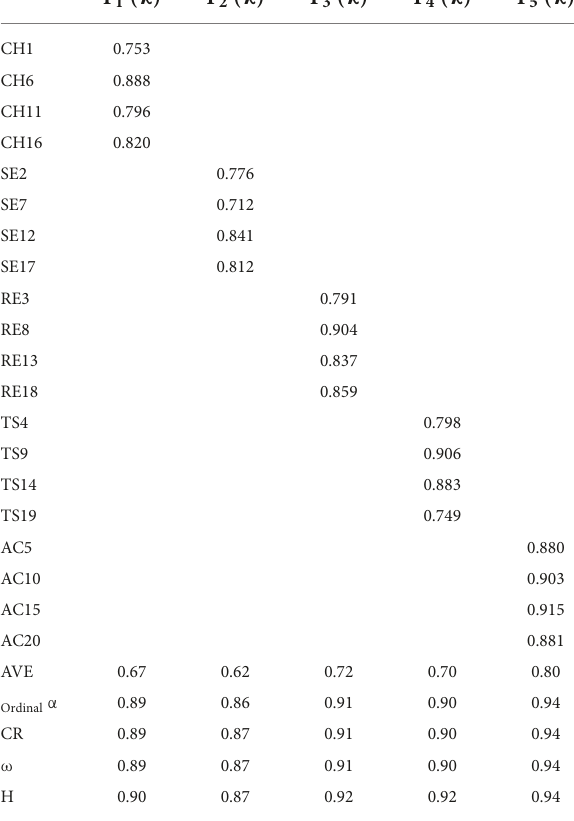
TABLE 2 Factor loadings and